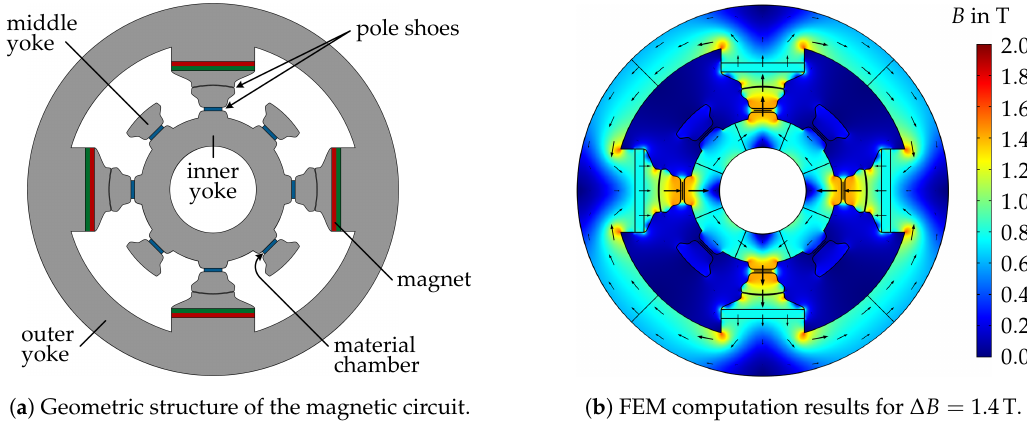
Figure 2. Design and computation results of the magnetic circuit